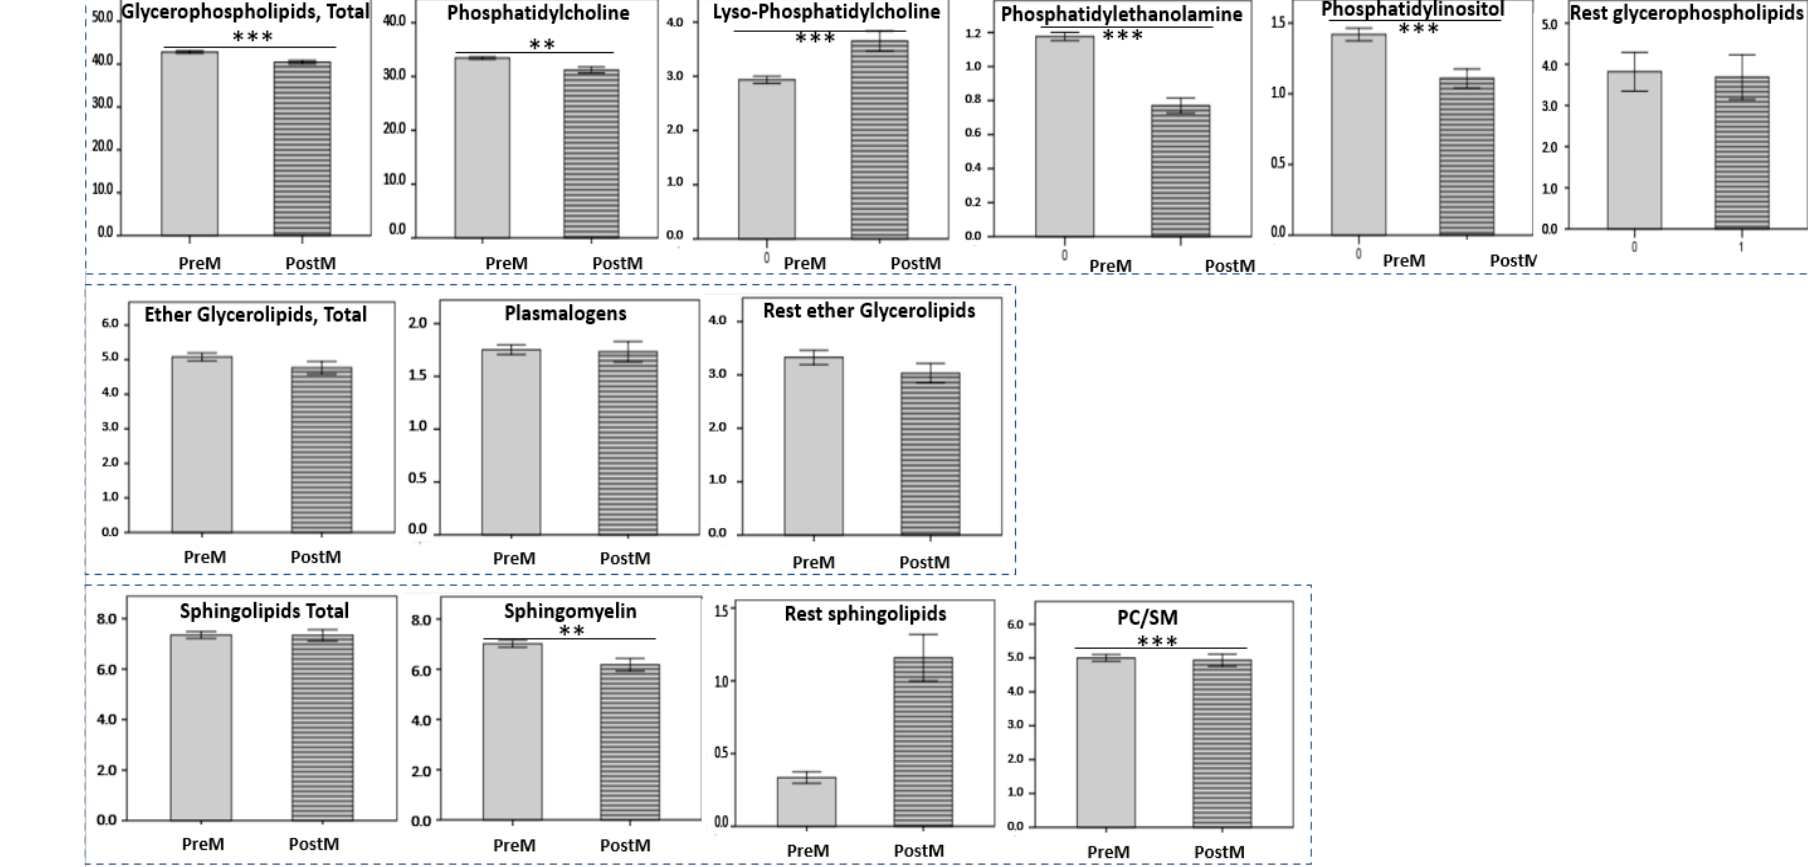
Figure 3. HDL phospholipid components and PC/SM ratio in the study groups (mean ± SD). PreM: premenopausal women, PostM: postmenopausal women. ** p